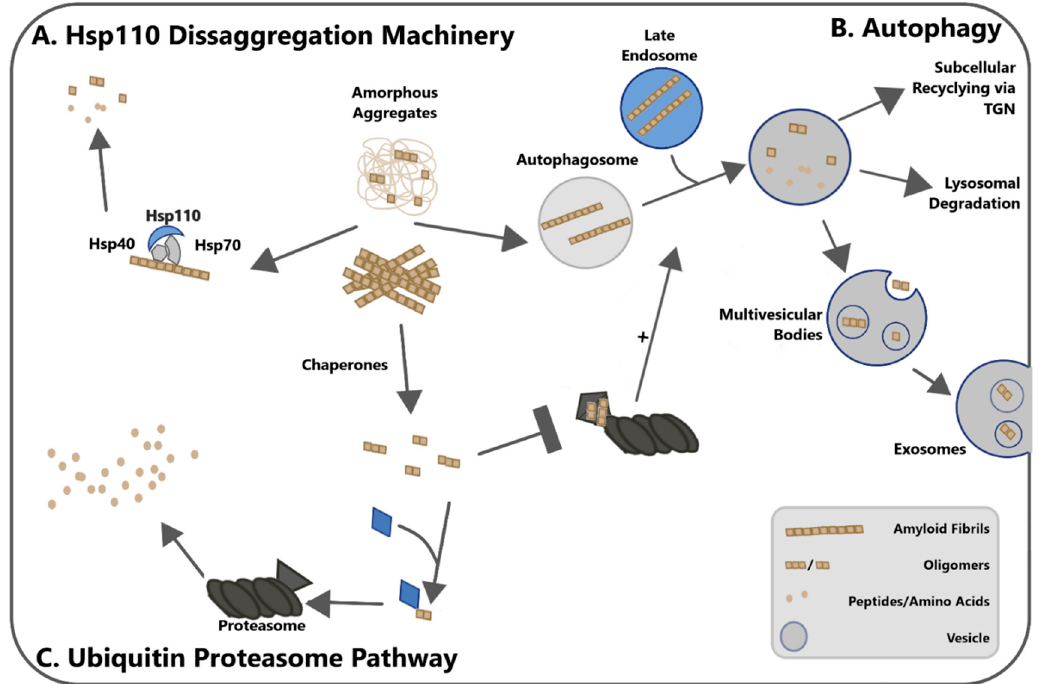
Figure 2. Schematic representation of cellular mechanisms involved in protein degradation and their proposed roles in fragmentation and seed generation. All pathways may start with either fibrillar aggregates or amorphous aggregates containing seeding-competent oligomers. ( A ) The Hsp70–